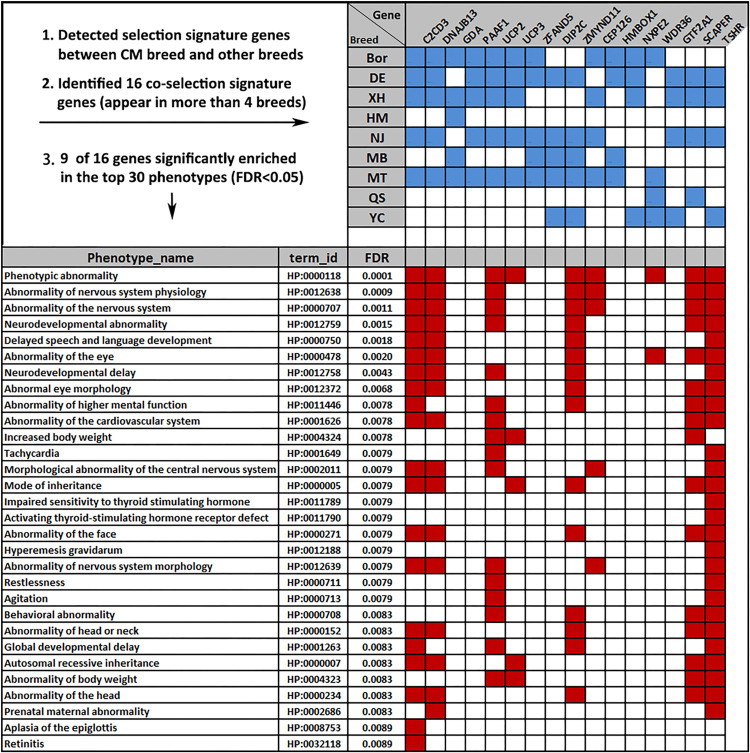
Phenotype overview of the 16 co-selection signature genes. Blue square indicates genes appearing in more than four of 10 breeds [false discovery rate (FDR) < 0.05]. Red squares indicate the nine genes enriched in the top 30 phenotype terms.